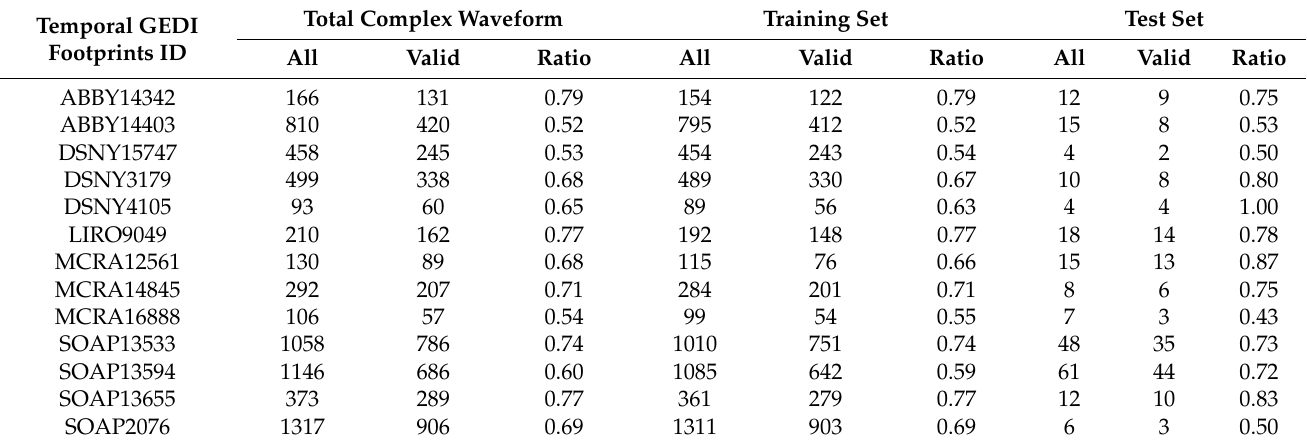
Table 7. The number of temporal GEDI footprints used in training and